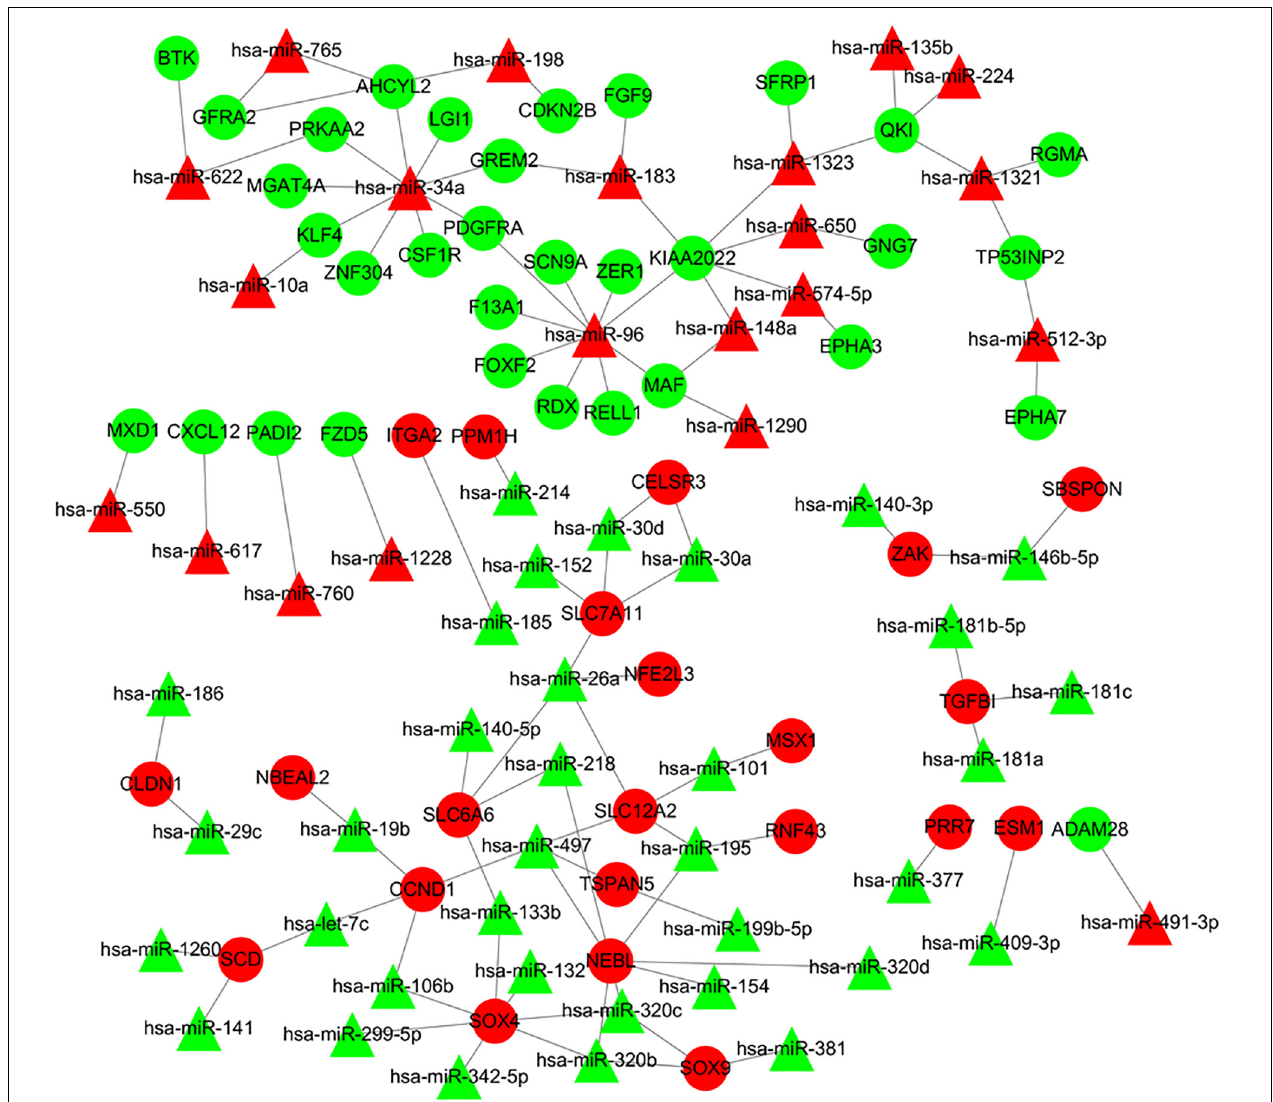
FIGURE 4 | Regulatory network of DEMs and their target DEGs in the comparison CRA samples versus normal samples. Red nodes and green nodes indicate upregulated genes/miRNAs and downregulated genes/miRNAs, respectively. Triangles represent DEMs and circles represent target DEGs. miRNAs, microRNAs; DEMs, differentially expressed miRNAs; DEGs, differentially expressed genes; CRA, colorectal